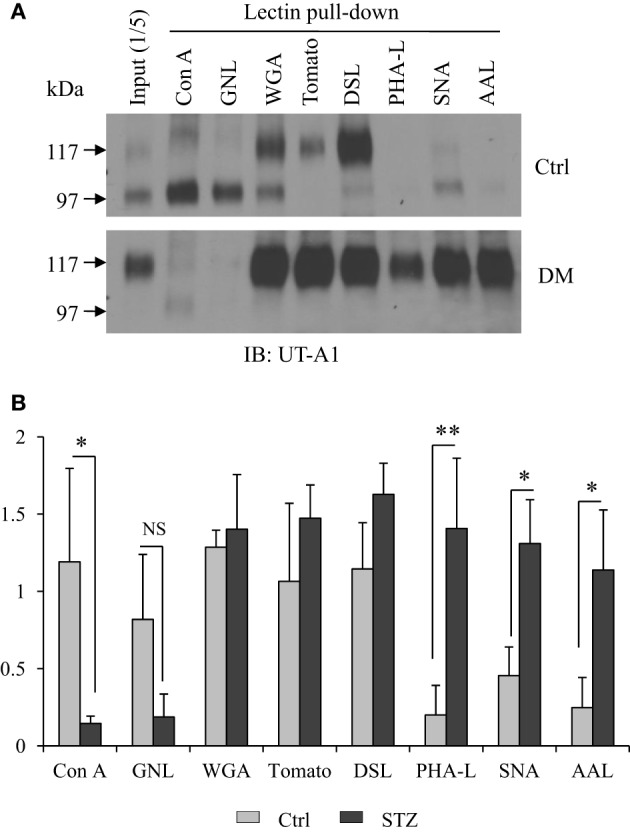
Lectin pulldown assays. (A) Cell membrane lipid raft fractions isolated from control or STZ-diabetic rat IM tip were pooled and incubated with 30 μl of indicated agarose-bound lectins at 4°C overnight. After washing, the lectin precipitated samples were analyzed by immunoblotting with anti-UT-A1 antibody. (B) Densitometry analysis of UT-A1 protein bands from three separate experiments (n = 3). Each lectin precipitated UT-A1 was normalized with UT-A1 from input proteins (means ± SD, *P < 0.05, **P < 0.01, NS, no significance).